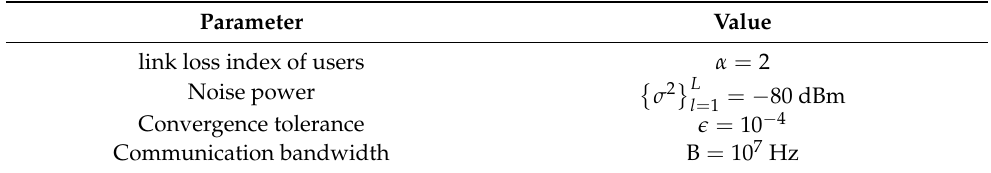
Table 1. Settings of simulation